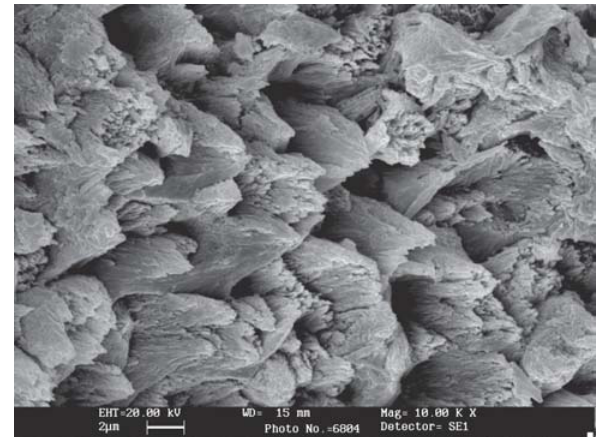
FIGURE 4- Fractured enamel surface of bleached specimens with 10% carbamide peroxide containing 0.5% fluoride stored in artificial saliva. The porosities at ends of fractured prisms were reduced